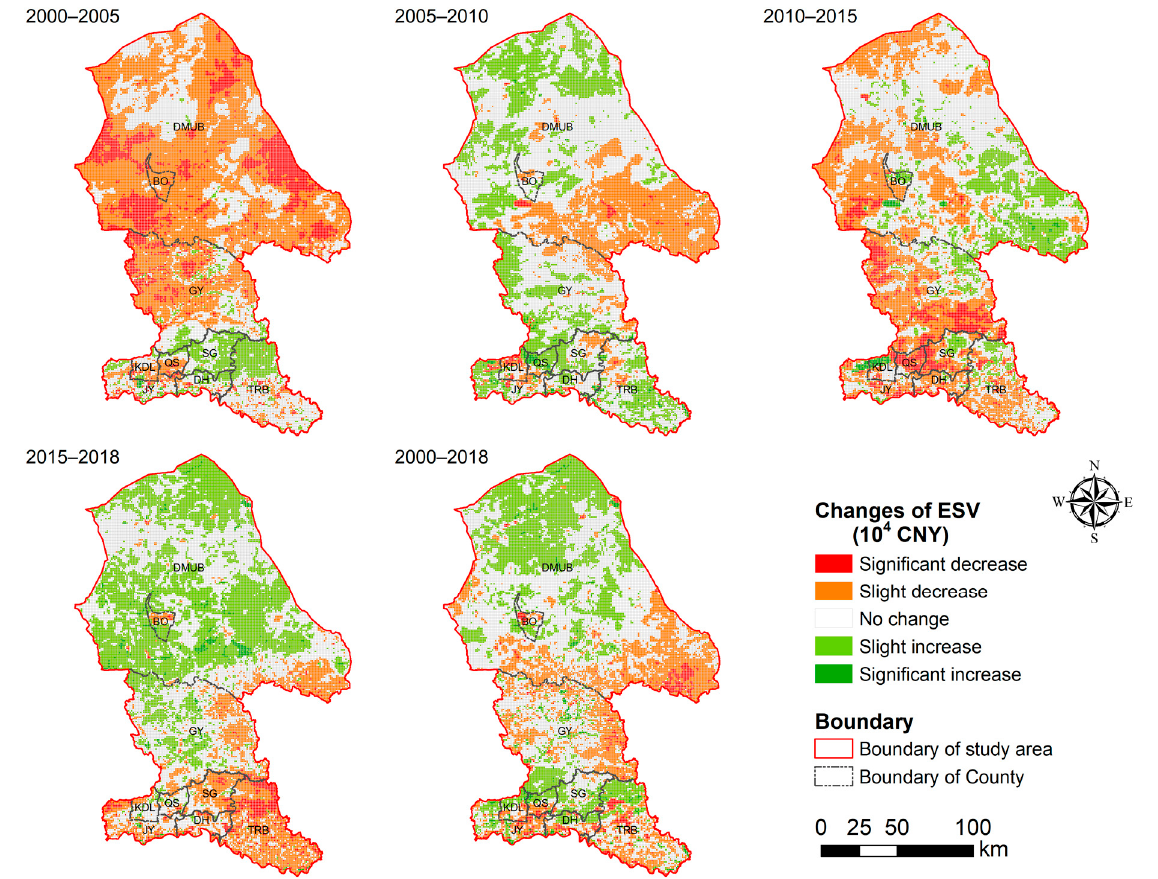
Figure 6. Spatial pattern of change in the Baotou ESV from 2000 to 2018. Table 4. Proportion of various ecosystem services in